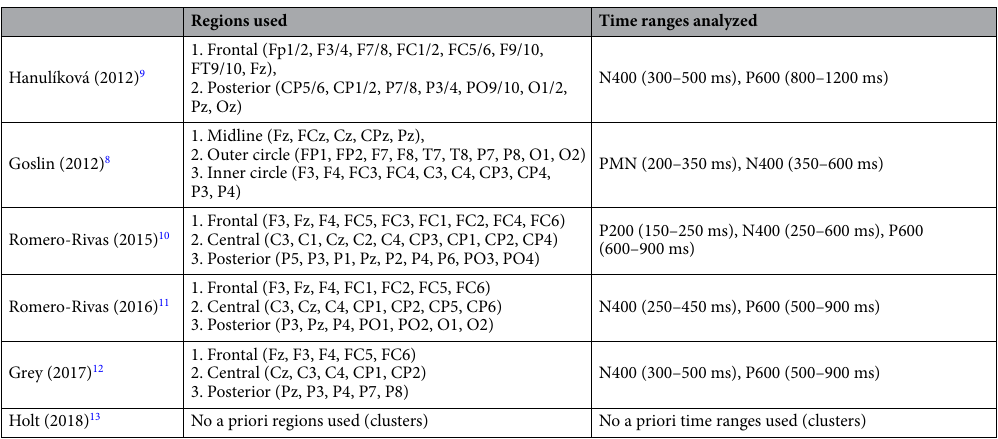
Table 1. Analytical parameters used in each ERP study of semantic congruence in accented